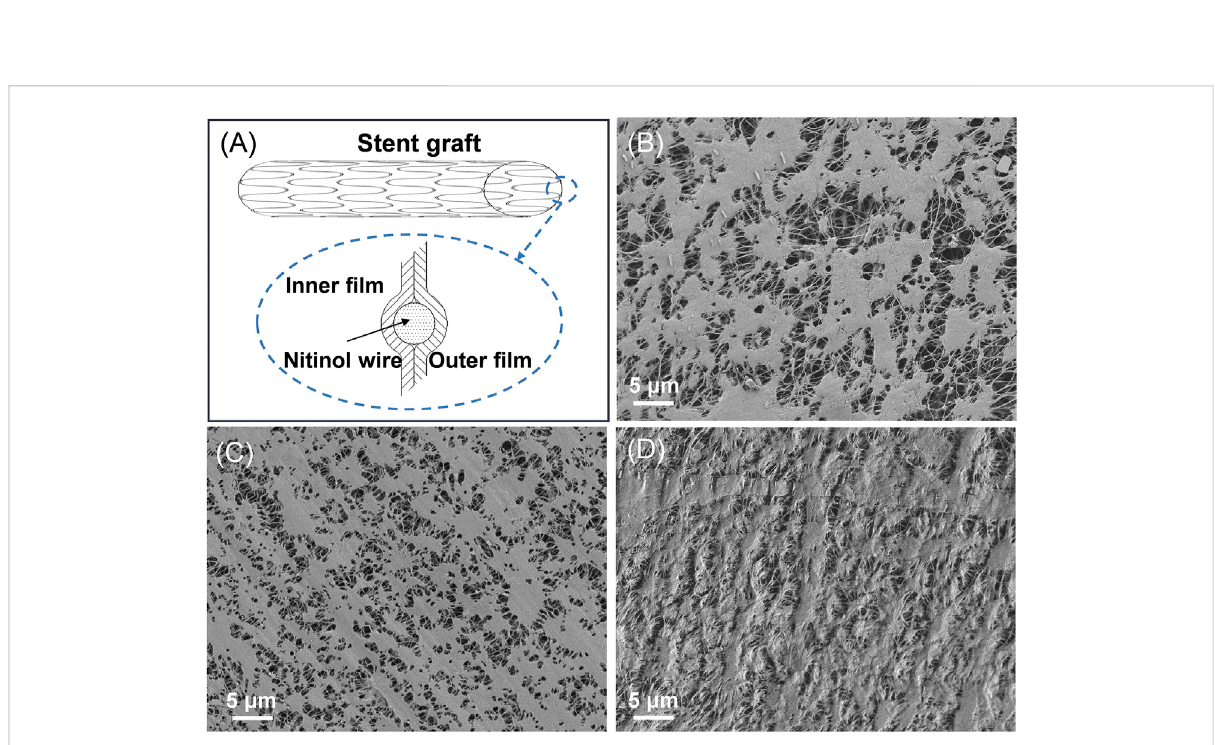
FIGURE 2 (A) Schematic diagram of the ePTFE-stent grafts, SEM images of the ePTFE-stent grafts, the (B) low-thickness group (C) medium-thickness group, and (D) high-thickness